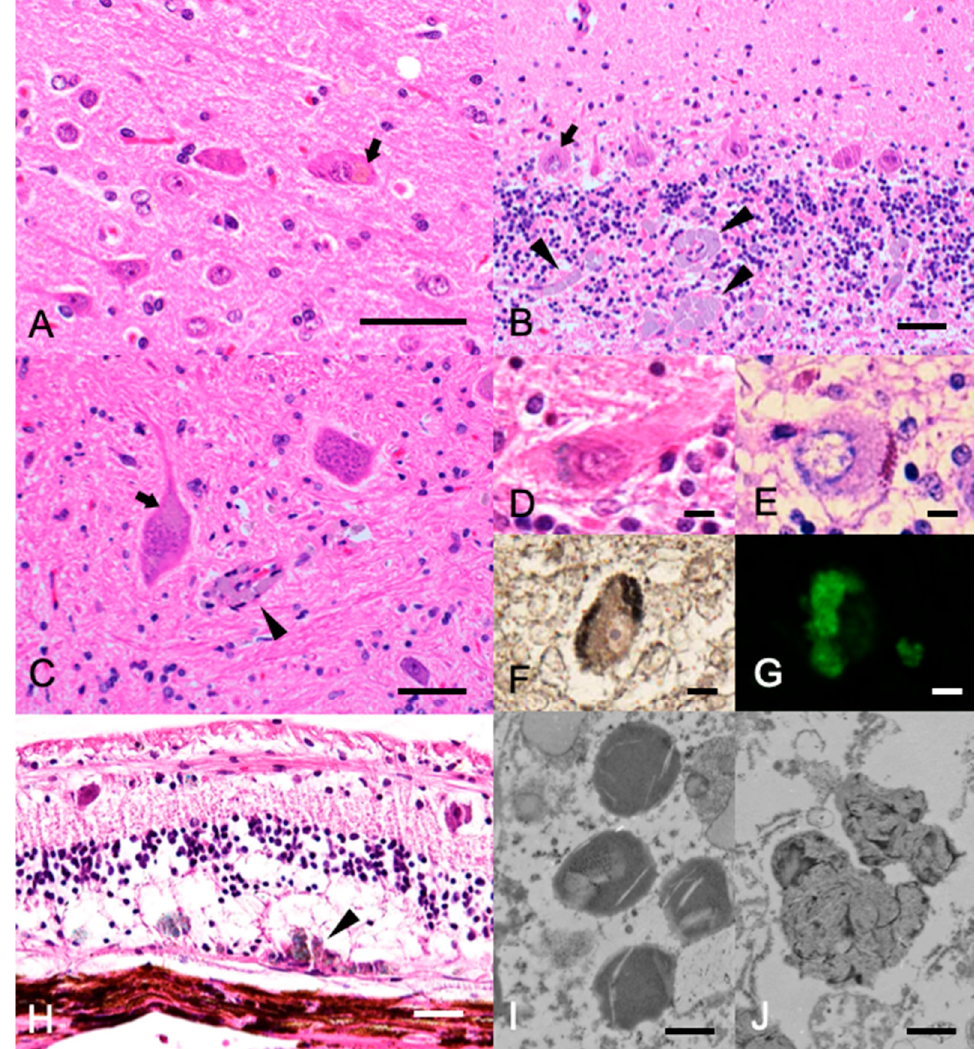
Figure 2. Histopathology of the ( A – C ) Hematoxylin and eosin stain of the cerebrum ( A ), cerebellum ( B ), and neuronal nuclei of the pons ( C ). Bars = 50 μ m. Light-brown pigments were frequently observed in the cytoplasm of large neurons (arrows). Note the pigment-phagocytosing macrophage infiltration in the perivascular region (arrowheads). ( D – F ) Histochemical staining of the cerebellum. Bars = 10 μ m. The accumulated pigments in the Purkinje cells appeared blue in Luxol fast blue-hematoxylin and eosin (LFB-HE) stain ( D ), purple in periodic acid–Schiff (PAS) stain ( E ), and black in Sudan Black B stain ( F ). ( G ) Fluorescence microscopy image of the cerebellum. The accumulated pigments in the Purkinje cells showed green autofluorescence. ( H ) LFB-HE stain of the retina. Bar = 50 μ m. The pigments were observed in the cytoplasm of the neuronal layer, and many macrophages phagocytosing the pigment were found at the border with the sclera (arrowheads). ( I , J ) Transmission electron microscopy of the storage bodies in neurons from the cerebellar Purkinje cells. Bar = 0.5 μ m. The bodies showed membrane-like components.